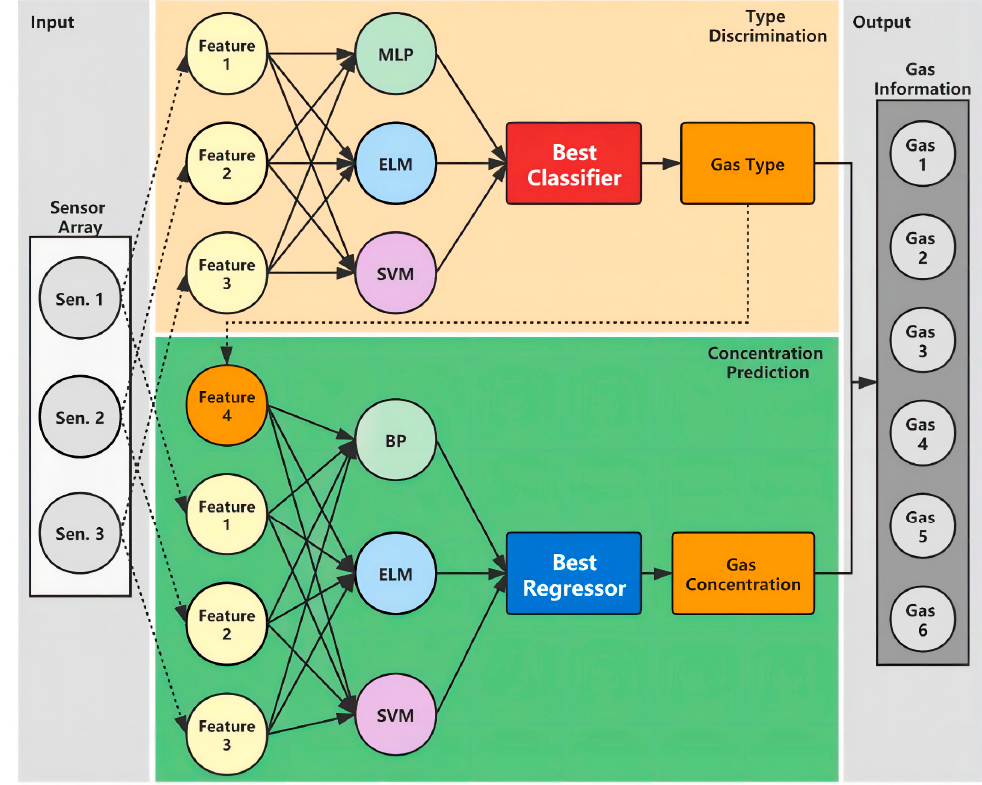
Figure 10. Schematic diagram of the integrated model, which can realize the type recognition and concentration prediction of 6 VOCs. Reprinted with permission from Ref. [90]. Copyright year 2022, copyright owner IEEE.